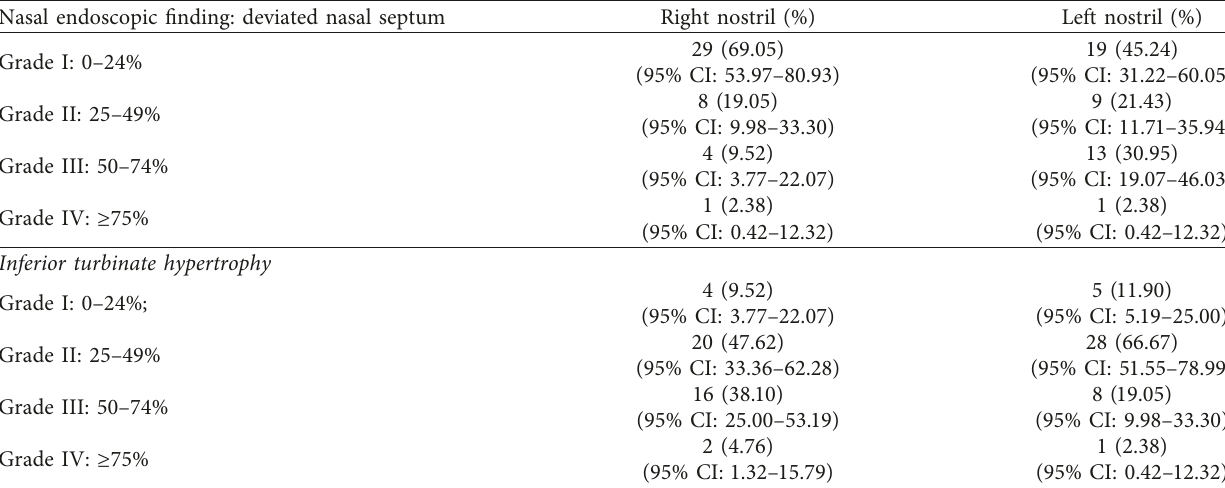
Table 2: Nasal endoscopic finding.